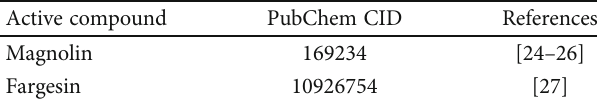
Table 1: Active compound of Magnolia